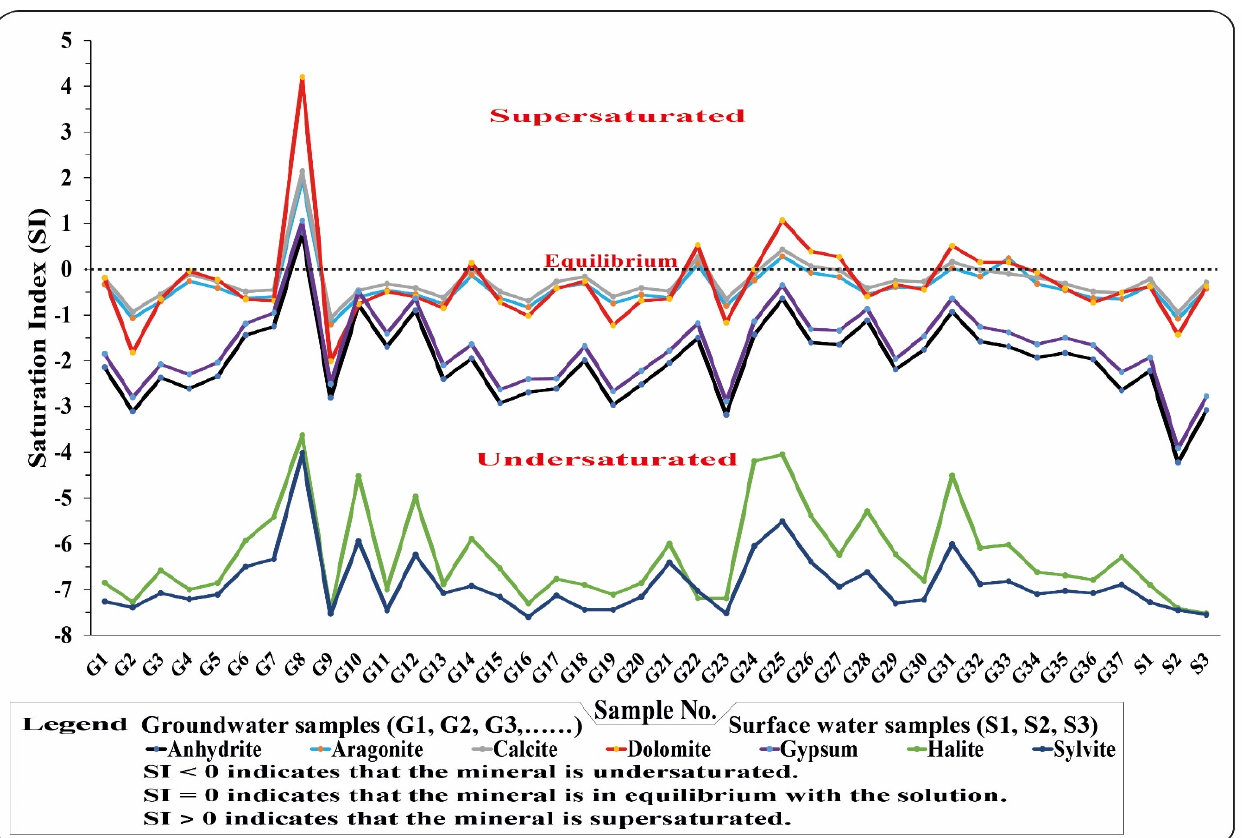
Figure 4. Saturation indices for the studied water.